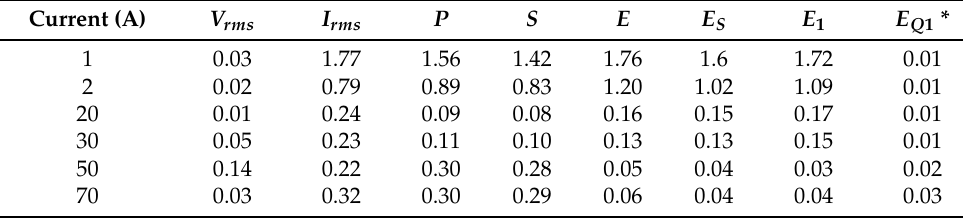
Table A3. Quadriform test results.